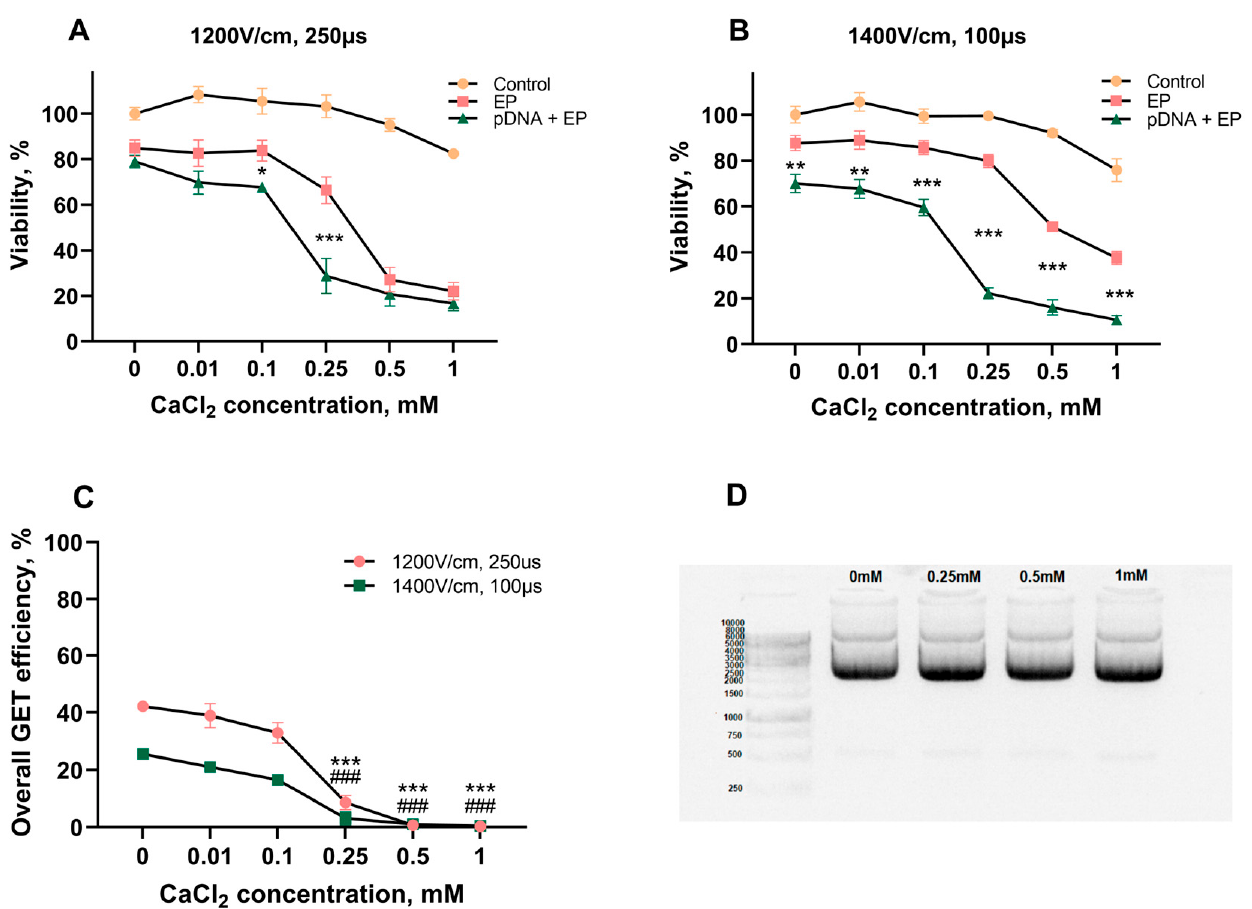
Figure 3. The effect of different CaCl 2 concentrations on cell viability ( A , B ), overall GET ( C ), and pDNA electrophoretic mobility ( D ). For panels A, B, and C, cells were treated using one square pulse of 1200 V/cm for 250 µ s or 1400 V/cm for 100 µ s. Results were evaluated 24 h after electroporation. Error bars represent the standard error of the mean (SEM) of n = 9 experimental replicates. In case standard errors were lower than actual data points, error bars are not visible. The statistical differences between calcium electroporation alone (pink squares) and in combination with pDNA (green triangles) at different CaCl 2 concentrations are denoted by *, **, and *** (Panels A and B). For panel C, the statistical significance between the control (0 mM) and the 0.1, 0.01, 0.25, 0.5, and 1 mM CaCl 2 concentrations is denoted by *** (1200 V/cm) and ### (1400 V/cm). * represents the p < 0.005, **— p < 0.01 and *** or ### represents p < 0.001. For panel D, pDNA was electroporated using a single 1200 V/cm, 250 µ s electric pulse; and electrophoretic mobility was evaluated via agarose gel electro- phoresis.